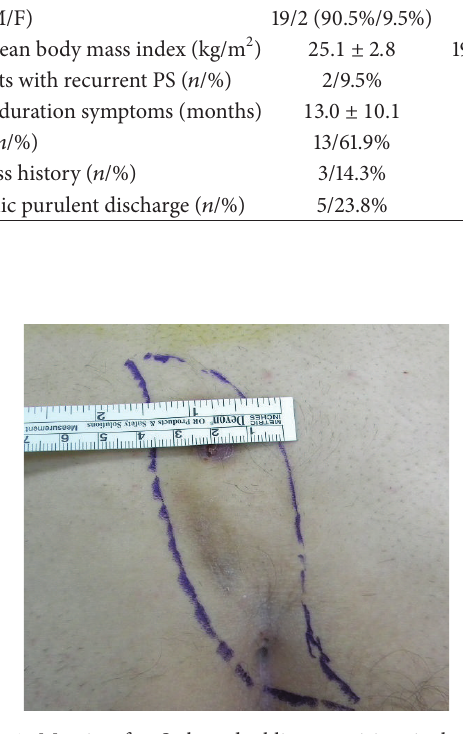
Figure 1: Margins for S-shaped oblique excision including the pilonidal sinus.